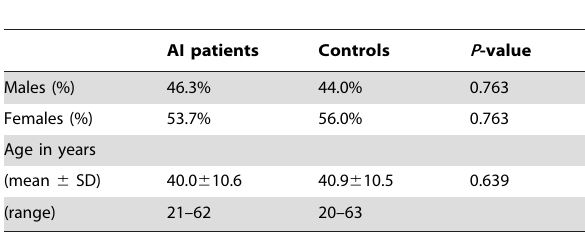
Table 1. Demographic characteristics of AI patients and